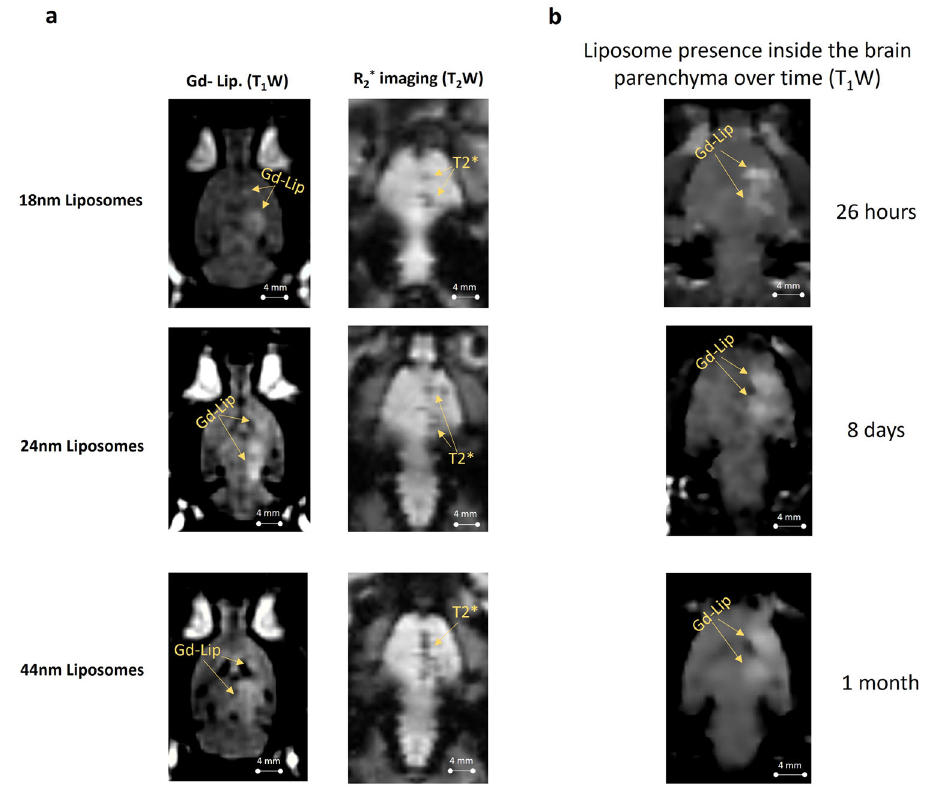
Fig. 4 Liposome presence inside the brain parenchyma. a Qualitative observation without registration alignment of different liposome populations ’ Gd signal ( T 1 -weighted imaging, left, white areas) and its treatment-related qualitative R 2 * changes ( T 2 -weighted imaging, right, dark areas); although no registration was performed, it noticeable that the liposome location correlated with the local R 2 * changes. b 44-nm liposomes presence inside the brain parenchyma over a period of 1 month. T 1 -weighted imaging parameters: FSE, TR: 500 ms, TE: 22 ms, ET: 4. T 2 -weighted imaging parameters: GRE, TR: 620 ms, TE: 38 ms; slice thickness: 2 mm, FOV: 18 cm, grid resolution: 224 × 224 were same for both the T 1 - and T 2 -weighted